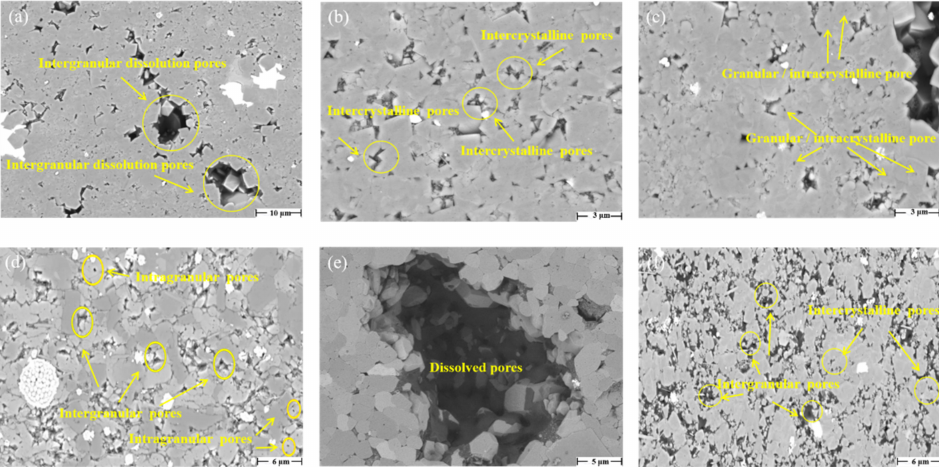
Figure 5. MAPS scan of sample A ( a – c ), B ( d , e ), and C ( f